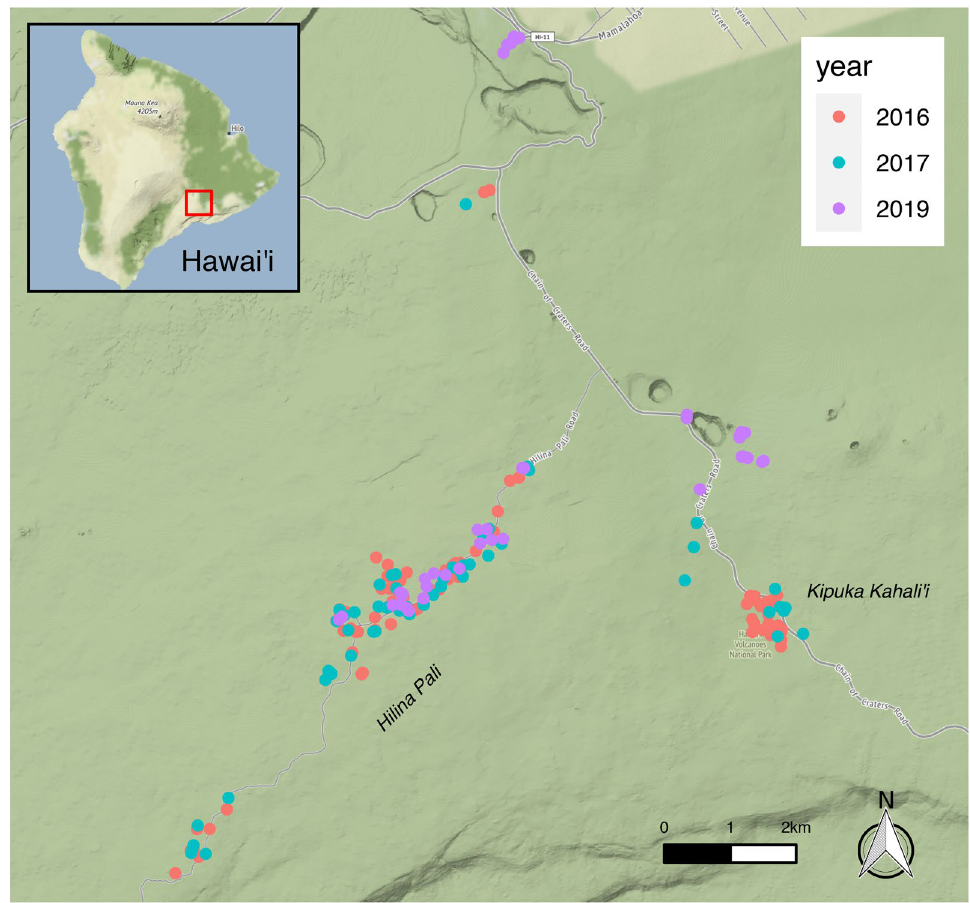
Figure 1. Locations of all colonies found in 2016, 2017 and 2019 in Hawaii Volcanoes National Park, on the Big Island of Hawaii. Most of the colonies in the study were located along Hilina Pali Road and at Kīpuka Kahali’i, in open ’Ohi’a forest approximately 850–1000 m above sea level. Basemap: Stamen Terrain (obtained through package ggmap 65